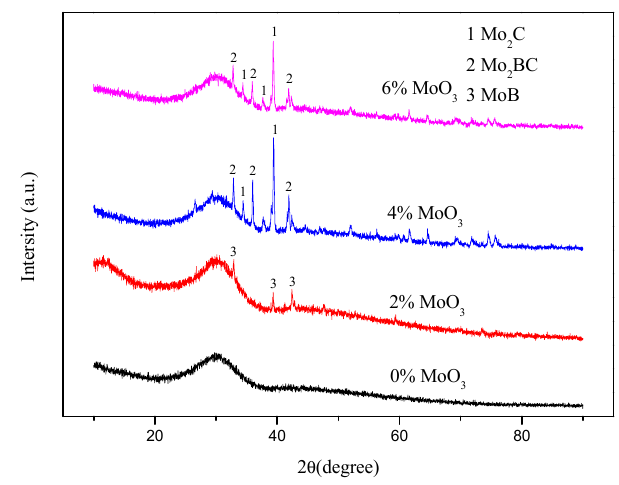
Figure 2. X-ray diffraction (XRD) patterns of disk samples with different MoO 3 contents.